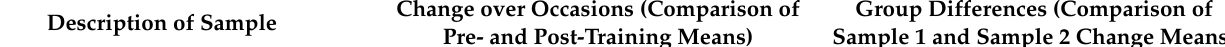
Table 2. Construct validity